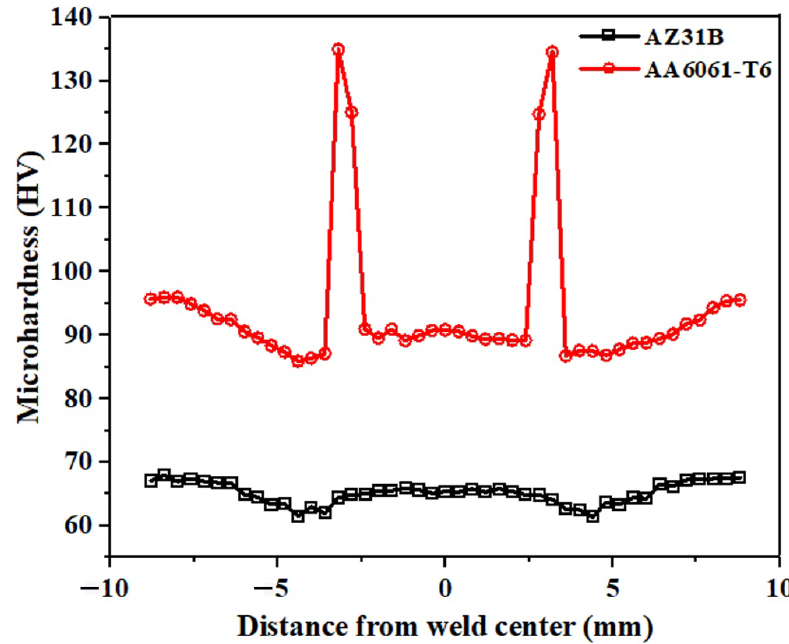
Figure 13. Hardness profile of dissimilar R-FSSW joint across the weld interface.